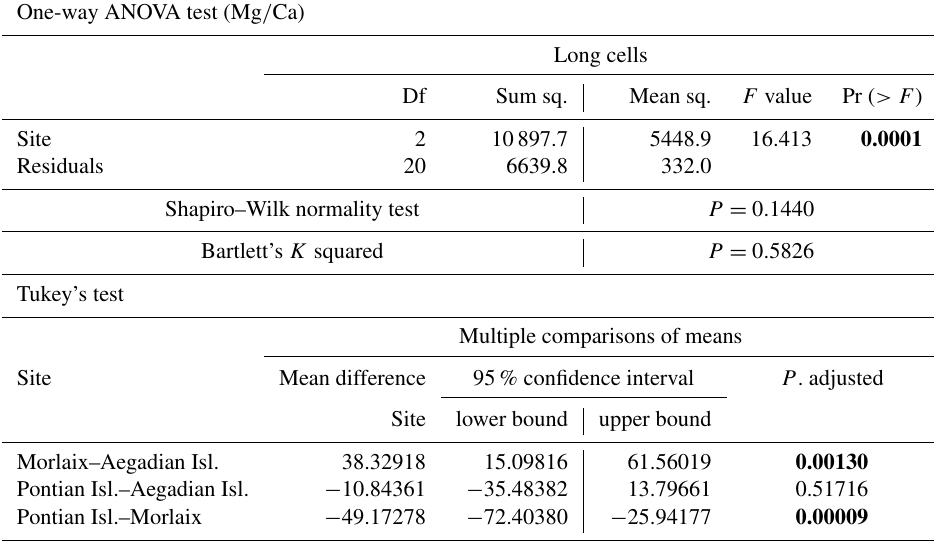
Table A2. Results of statistical tests performed to evaluate the differences of Mg / Ca in the long cells of L. corallioides collected at different sampling sites. Statistically significant p values are given in bold. ANOVA test significance at α = 0 . 05; Tukey’s test significant at p ≤ α .